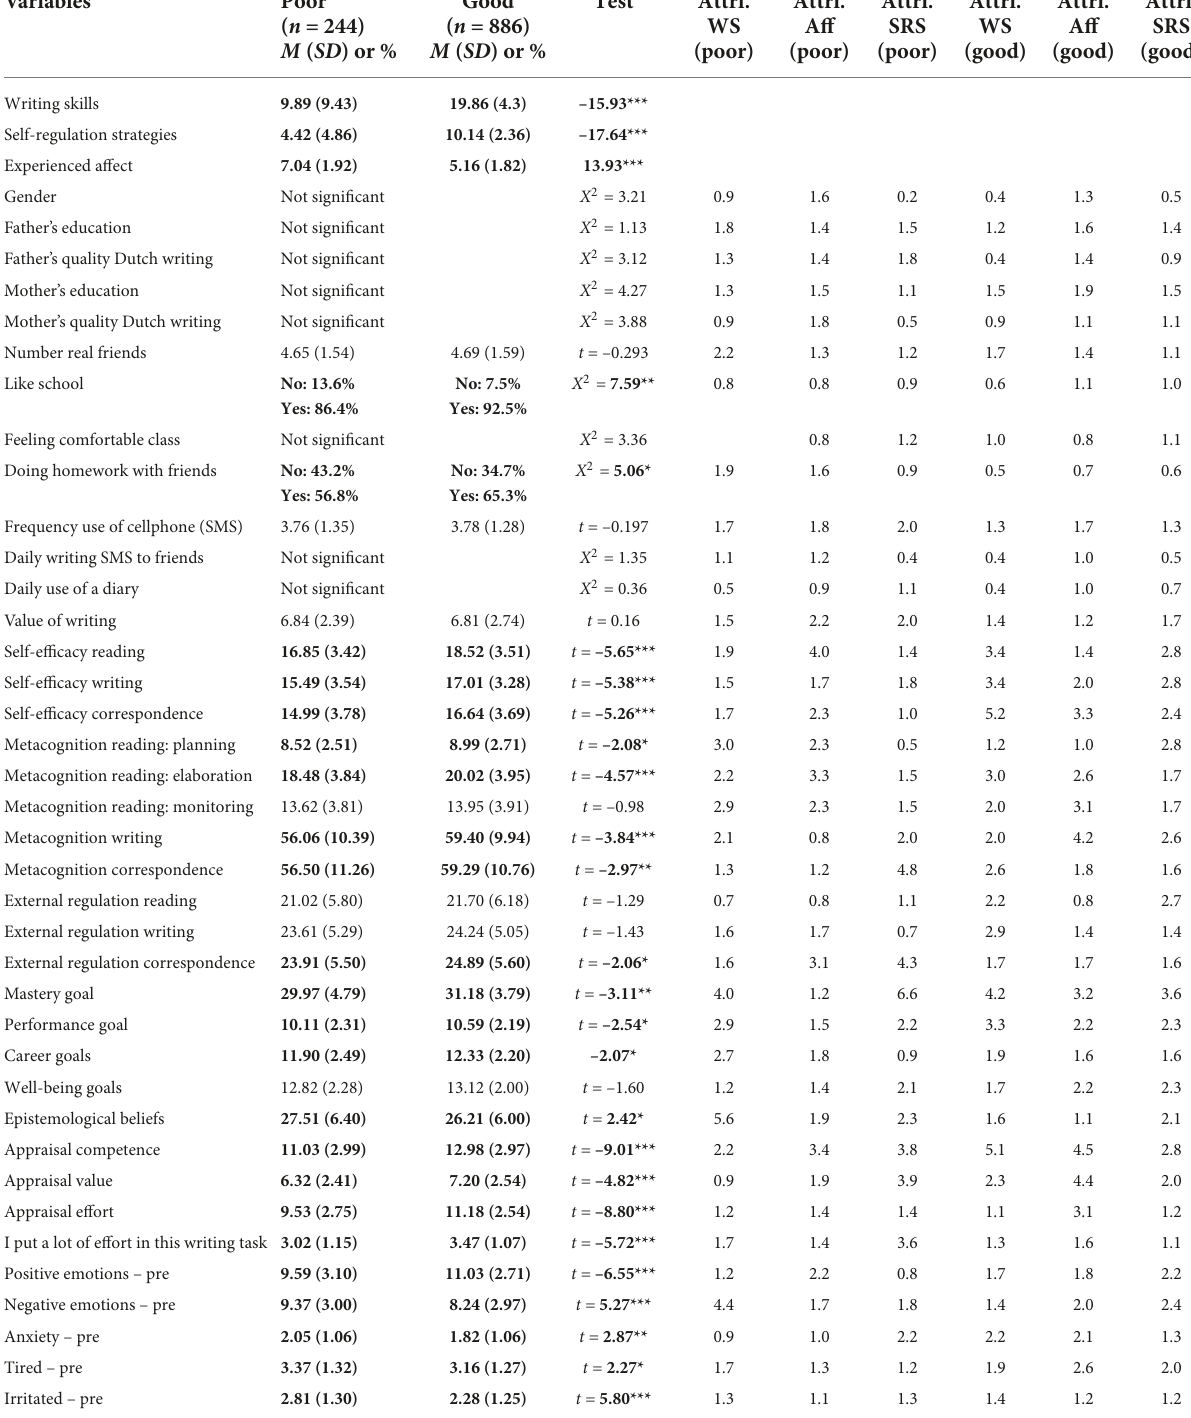
TABLE 4 Descriptive statistics and T -tests for all variables (left half), and predictive weights of the predictor variables in the six neural networks separately for the three good and the three poor groups (last six columns). Variables Attri.